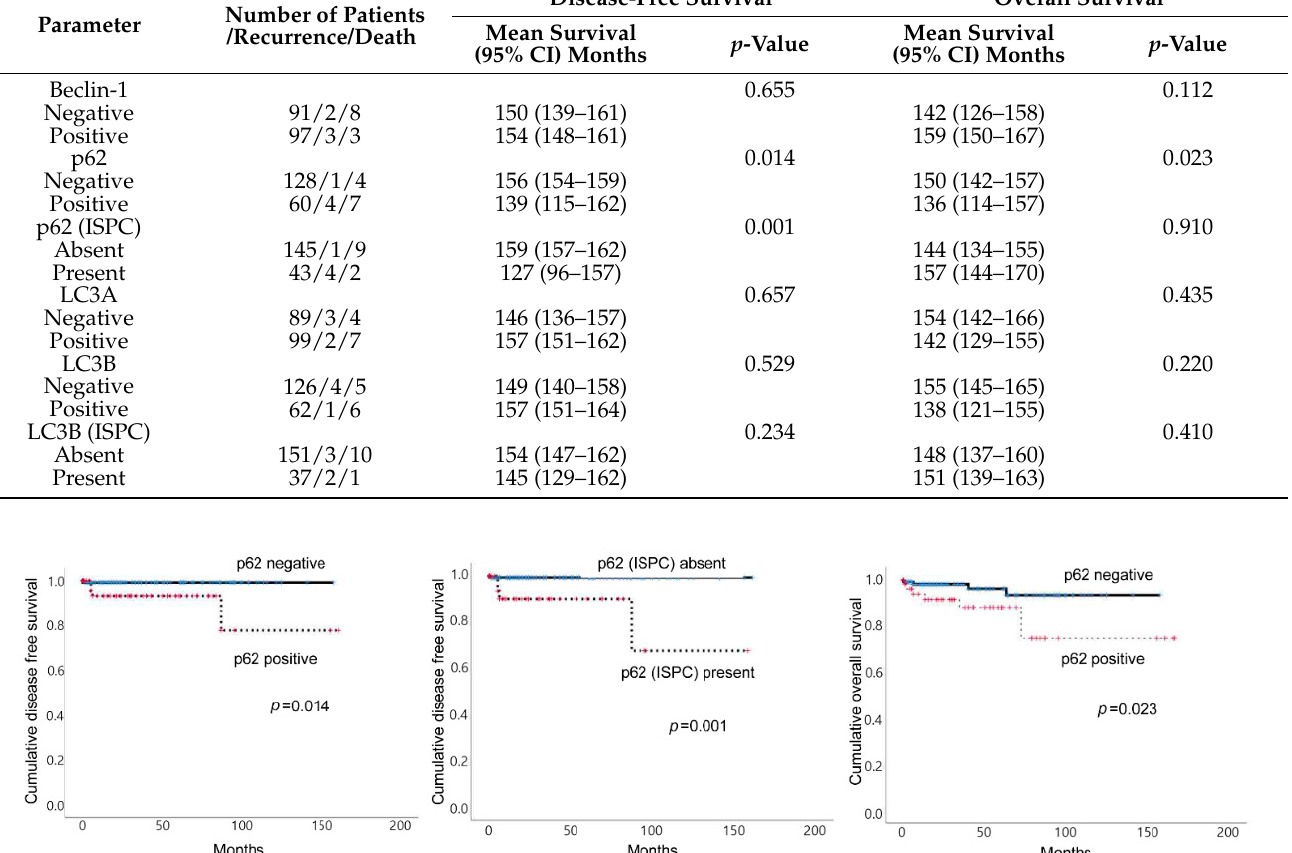
Figure 4. Impact of the expression of autophagy-related proteins on prognosis in pheochromocytoma. The p62 (left figure) and p62 (ISPC) (middle figure) positivity was associated with shorter disease-free survival in PCC, whereas p62 positivity was also associated with shorter overall survival (right figure).